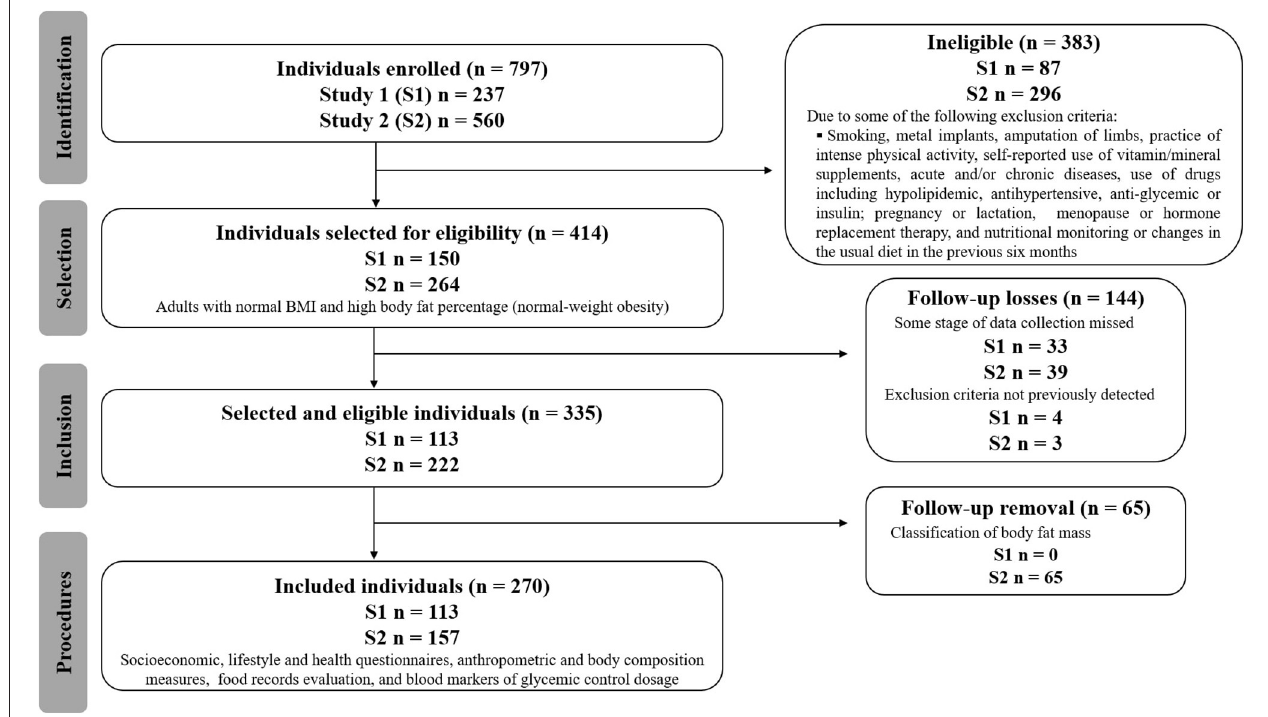
FIGURE 1 | The Strengthening the Reporting of Observational Studies in Epidemiology (STROBE) flow-chart of